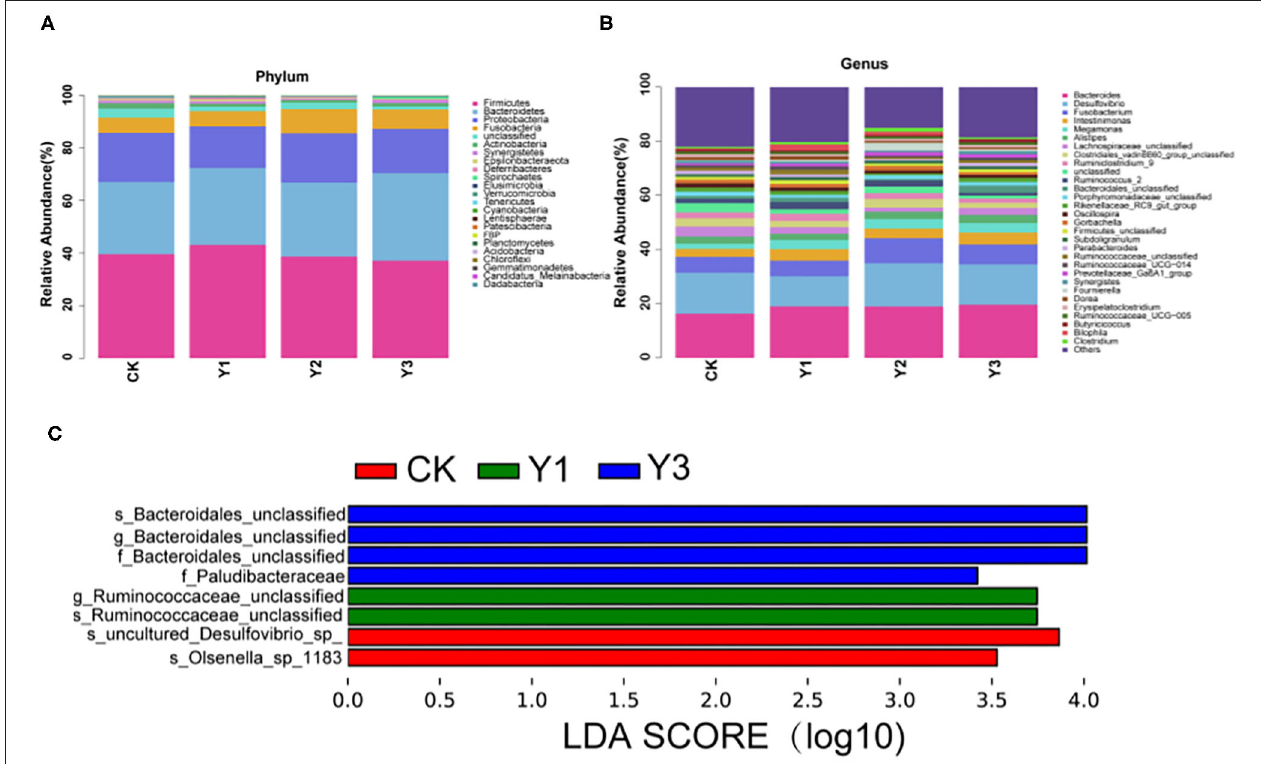
FIGURE 4 | Effect of dietary AOE on microbial composition in cecum feces of ducks. (A) The abundance of the top 15 bacteria at phylum level. (B) The abundance of the top 15 bacteria at the genus level. (C) LEfSe Analysis. LDA, linear discriminant analysis.